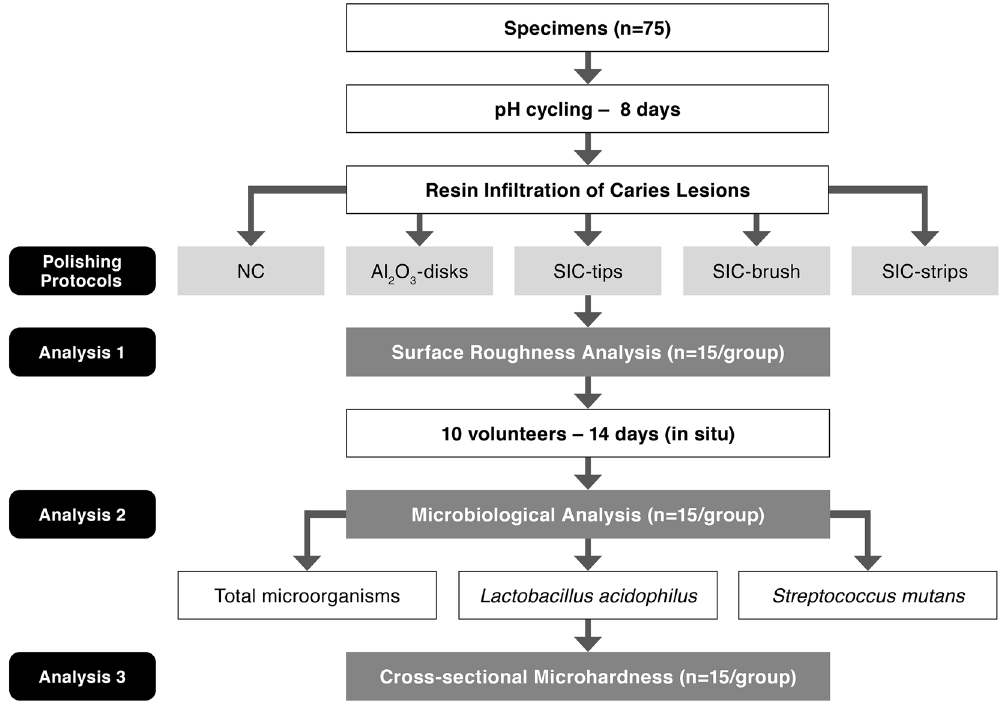
Figure 2. Flow-chart of the in situ study. Analysis of surface roughness was performed before the in situ phase and microbiological as well as cross-sectional microhardness afterwards. Samples distributions for each analysis (n = 15/group) by each